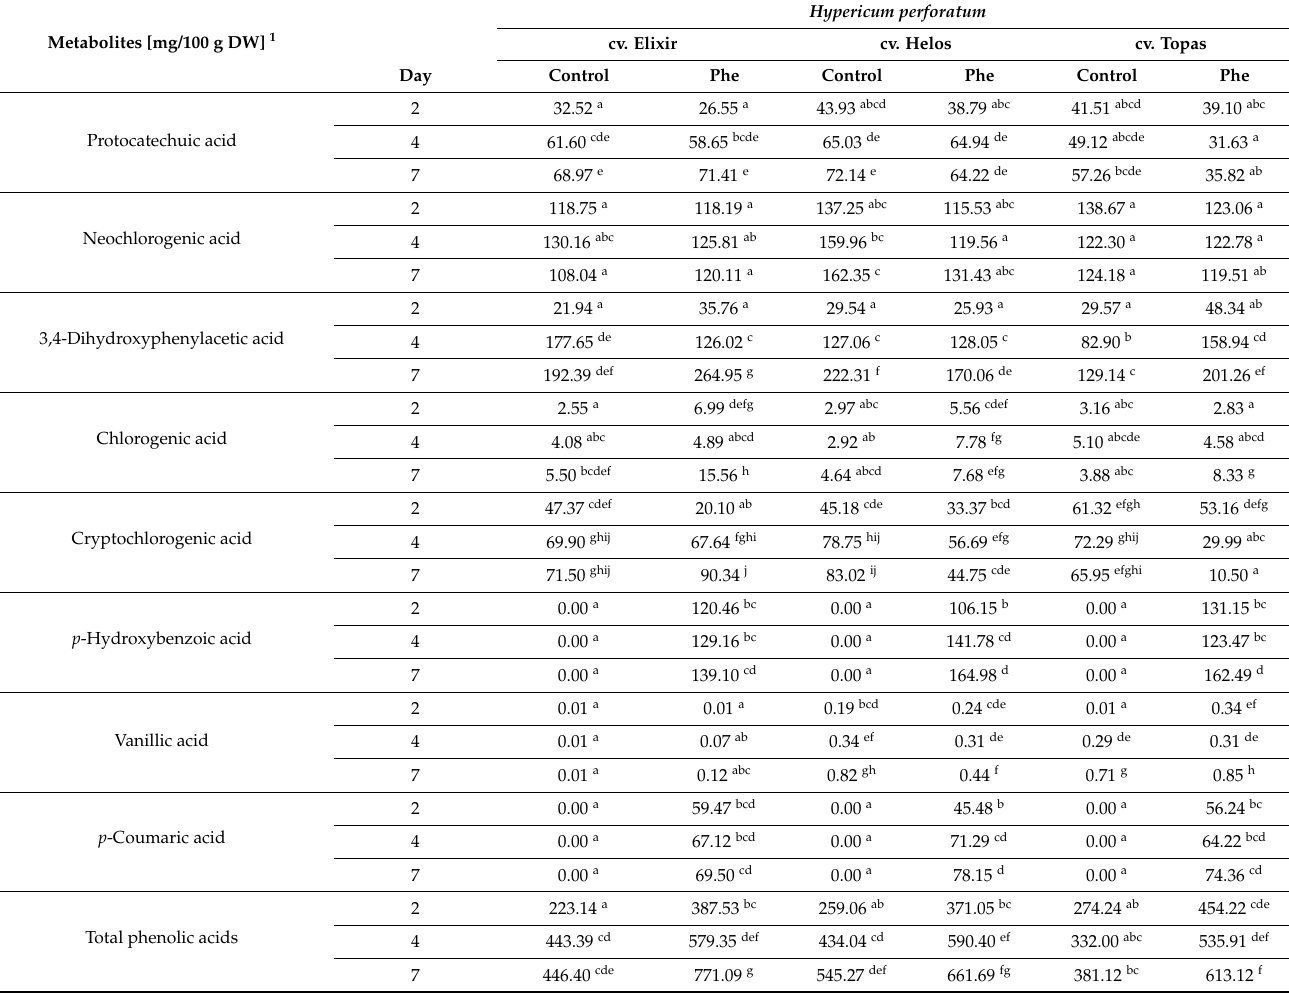
Table 5. Metabolite content in the biomass extracts from agitated in vitro cultures of three H. perforatum cultivars supplemented with phenylalanine 1 g/L (MS, 0.1 mg/L BAP and 0.1 mg/L NAA). Values were determined on days 2, 4, and 7 after the addition of the